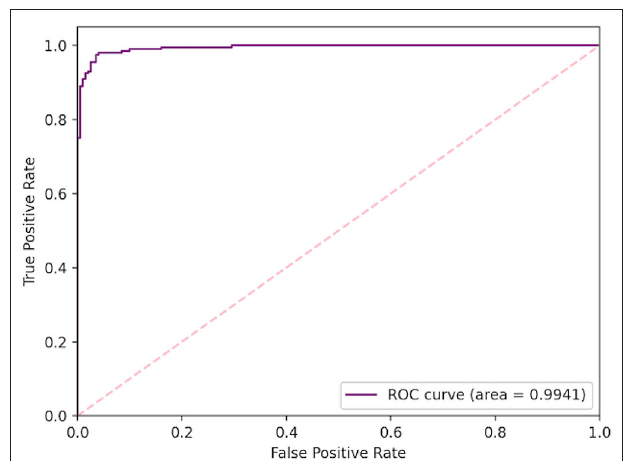
FIGURE 5 | Quantitative analysis. Receiver operating characteristic (ROC) curve for COVID-Net CXR-2 SARS-CoV-2 positive and negative CXR classification, with a computed area under curve (AUC) of